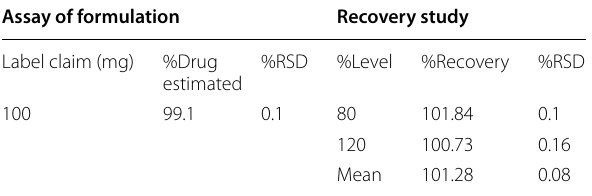
Table 11 Regression data for the calibration curve. ( n